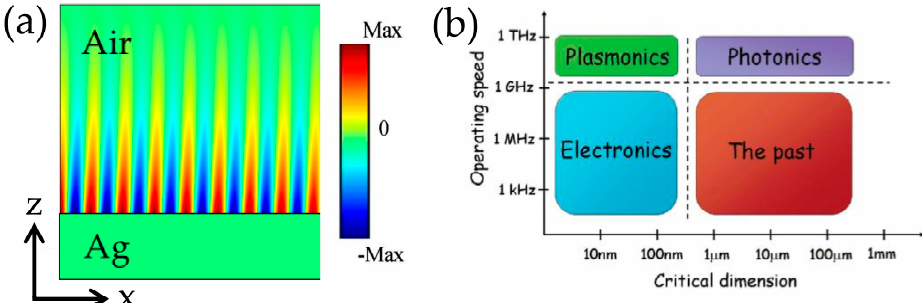
Figure 2. ( a ) Optical field profile ( E z ) of surface plasmons on the air–Ag interface. ( b ) The operating speed and device sizes of semiconductor electronics, dielectric photonics, and plasmonics. Plasmonics can bridge the gap between nanoelectronics and photonics.